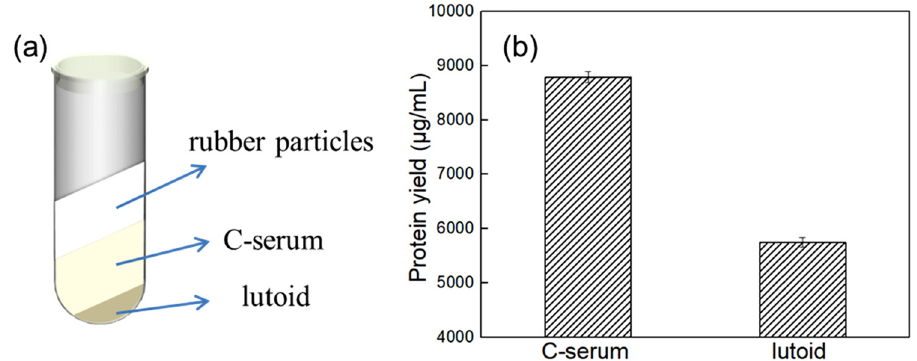
Figure 1: ( a ) Three fractions of NR latex are centrifuged; ( b ) the protein content of C - serum and